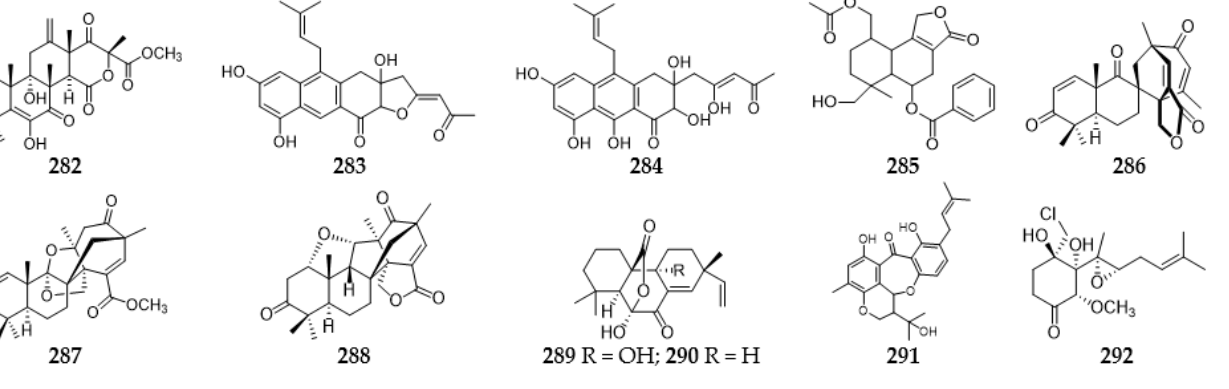
Figure 18. Aspergillus -derived meroterpenoids ( 282 – 292